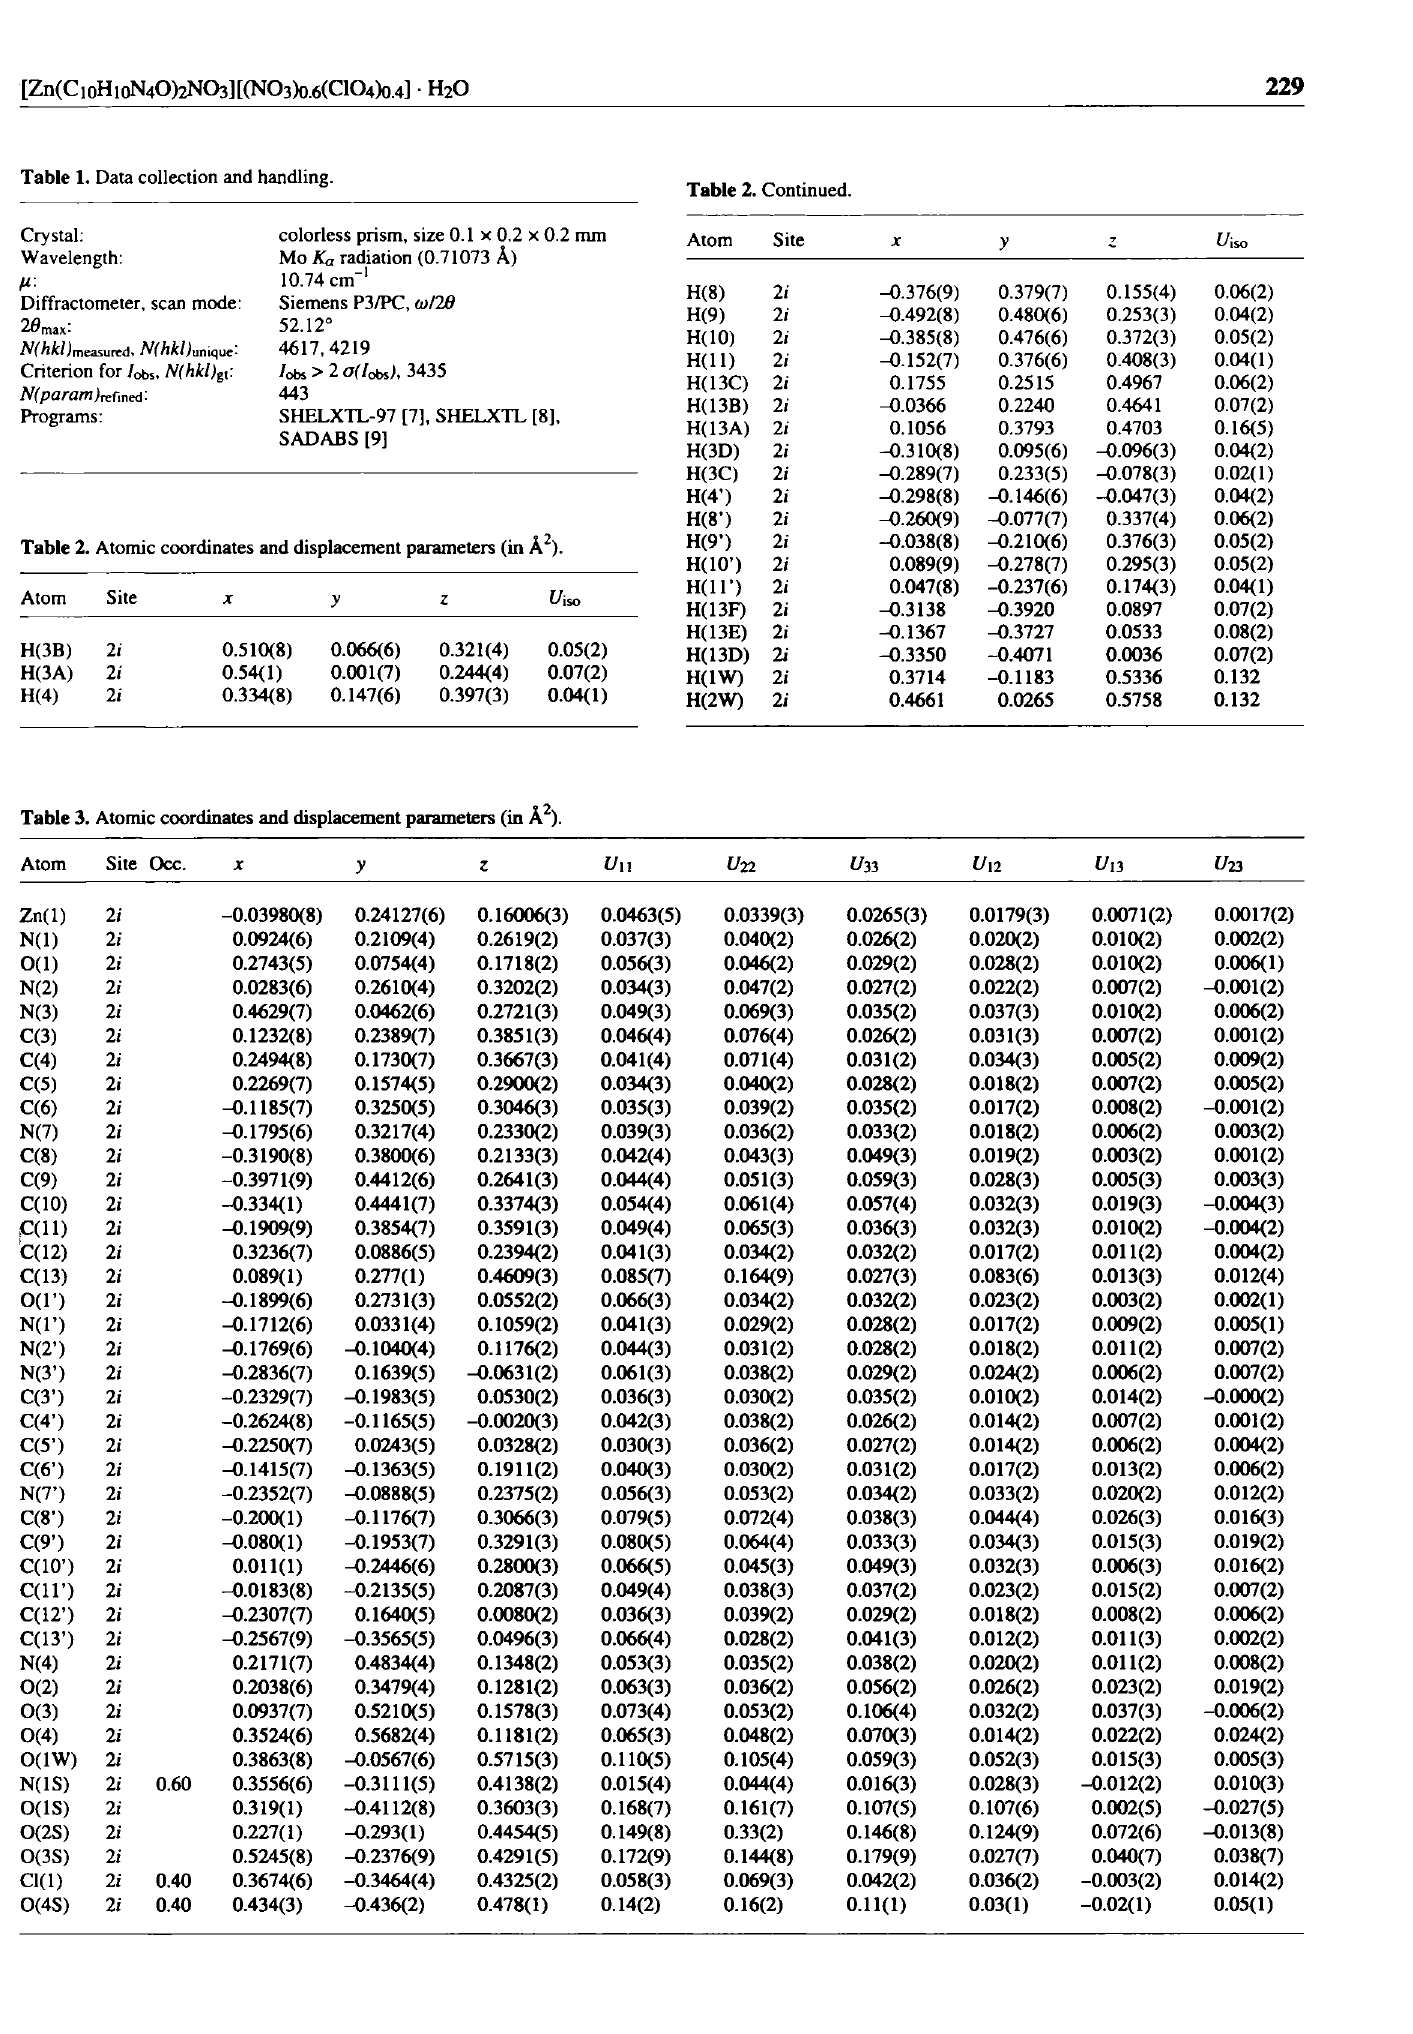
Table 2. Atomic coordinates and displacement parameters (in Â 2 ).